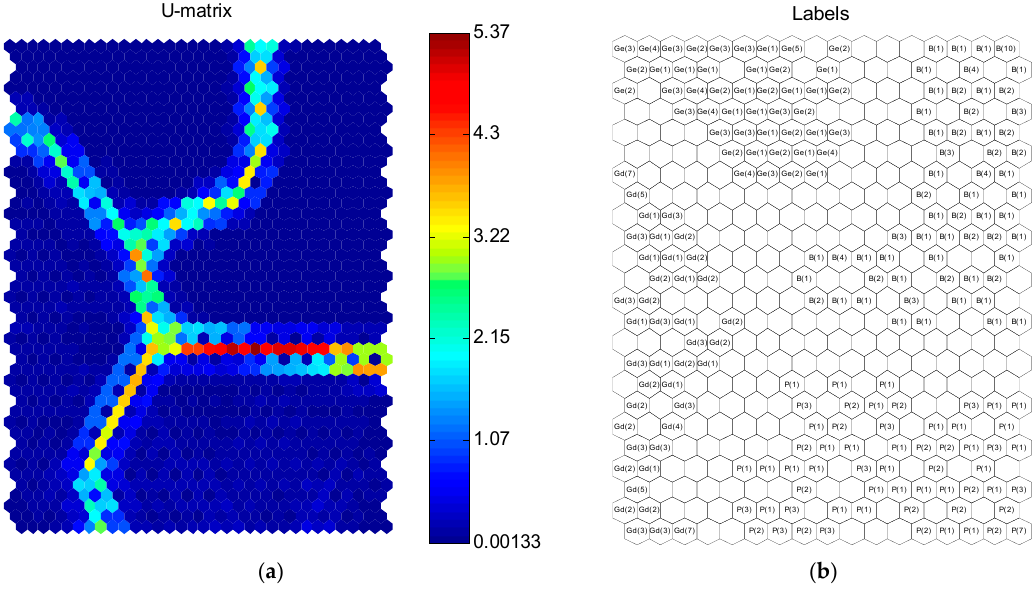
Figure 5. Visual monitoring model based on subtractive clustering. ( a ) U-matrix map; ( b ) training map.